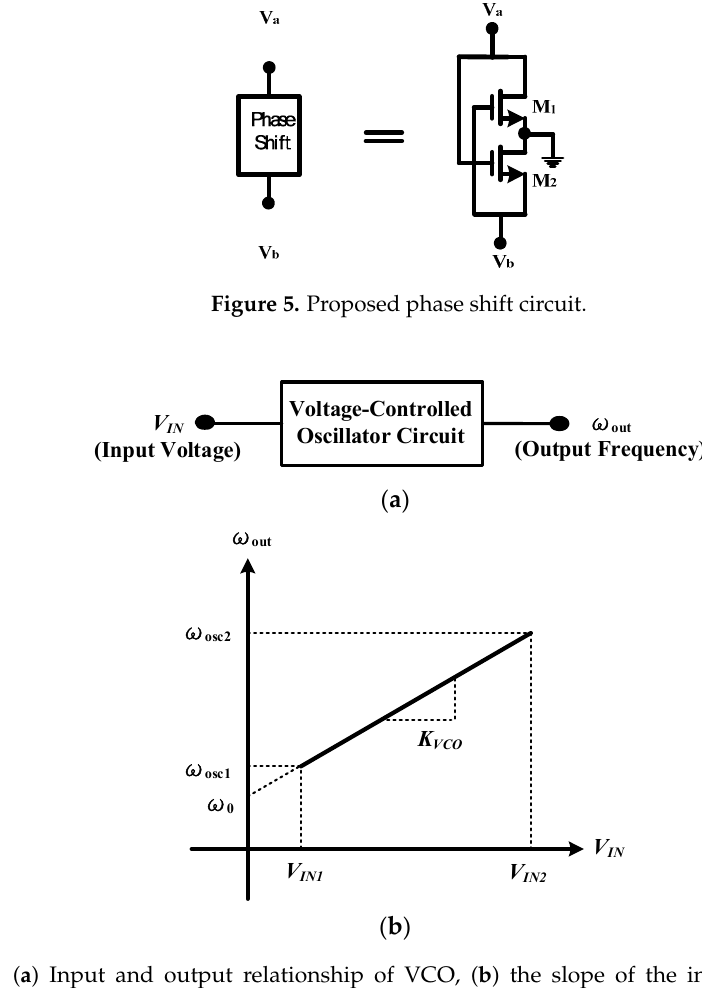
Figure 6. ( a ) Input and output relationship of VCO, ( b ) the slope of the input voltage to the output frequency.